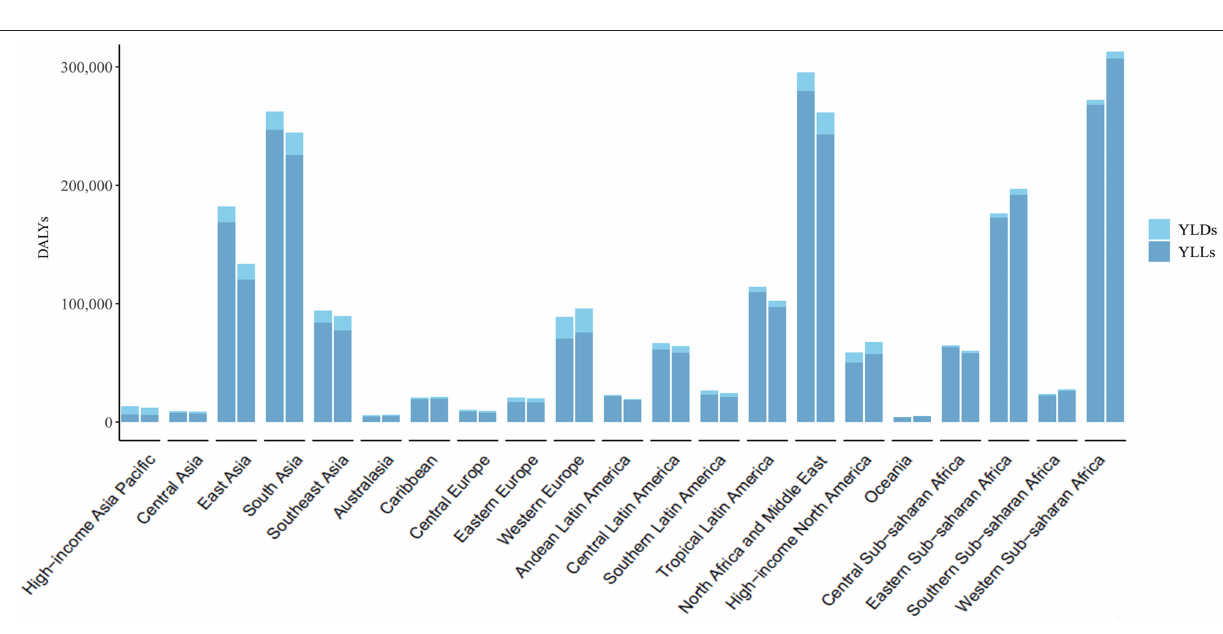
complications, and it is more difficult to establish a complete